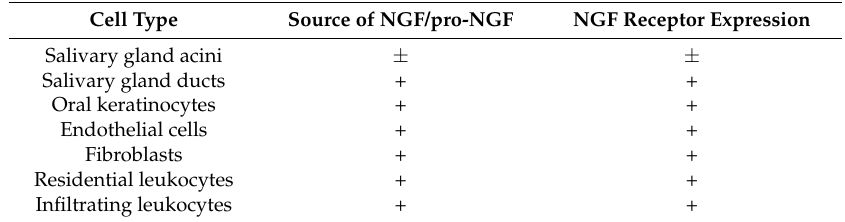
Table 1. Sources of Nerve Growth Factor (NGF) and expression of its receptors in human salivary glands and the oral cavity.